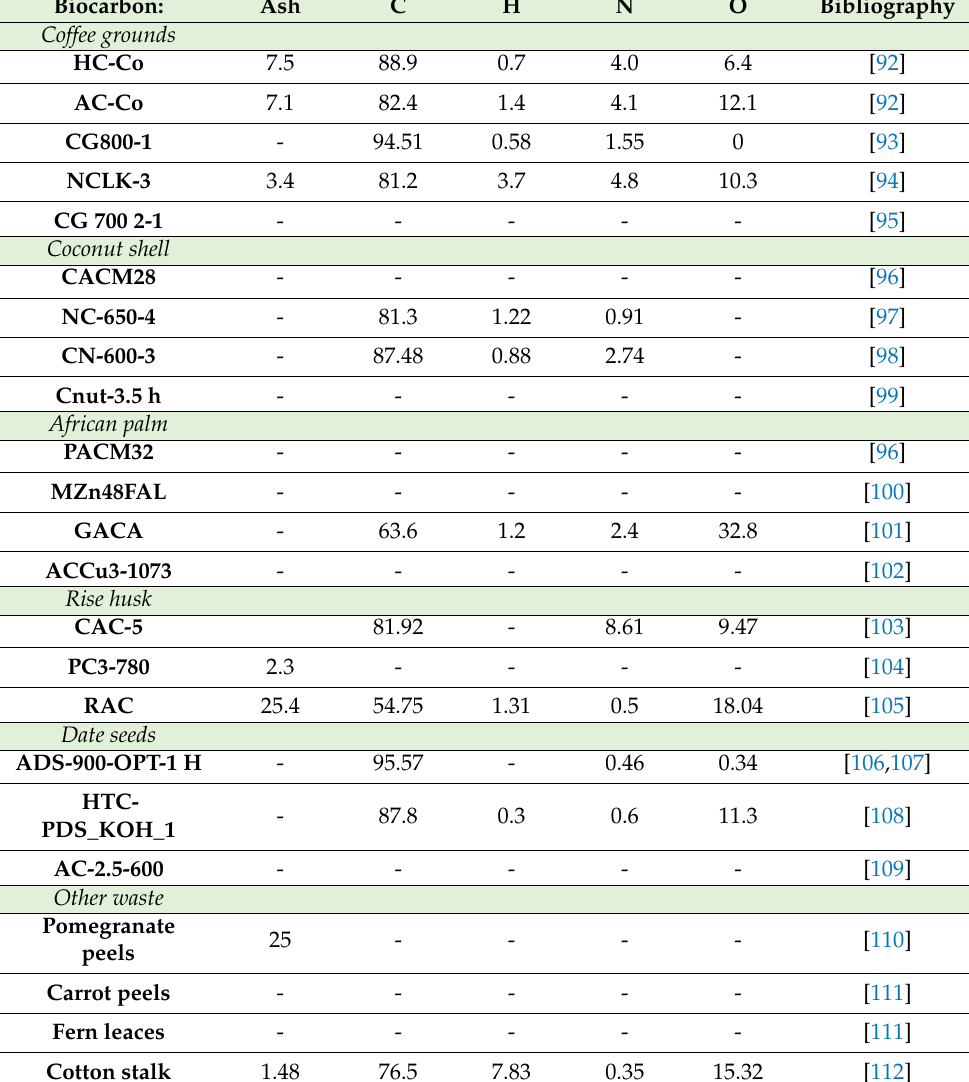
Table 5. Ultimate analysis of the percentage of ash and elements in bioadsorbents (wt.%).